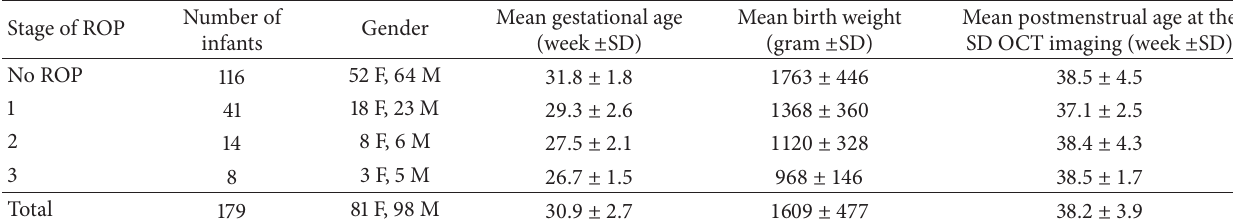
Table 1: Demographic characteristics of infants.